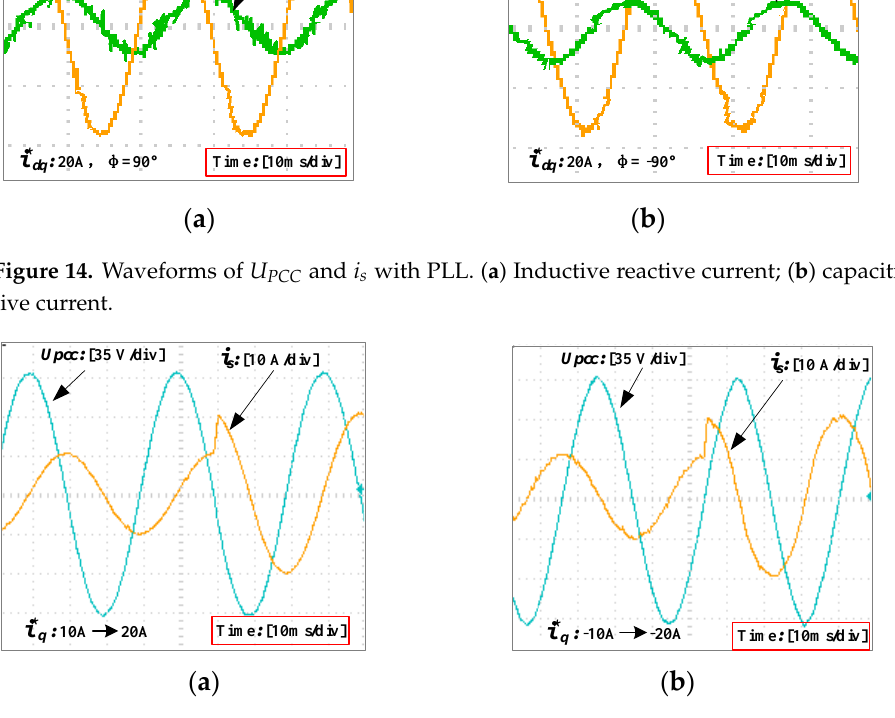
changes from 10 A to 20 q